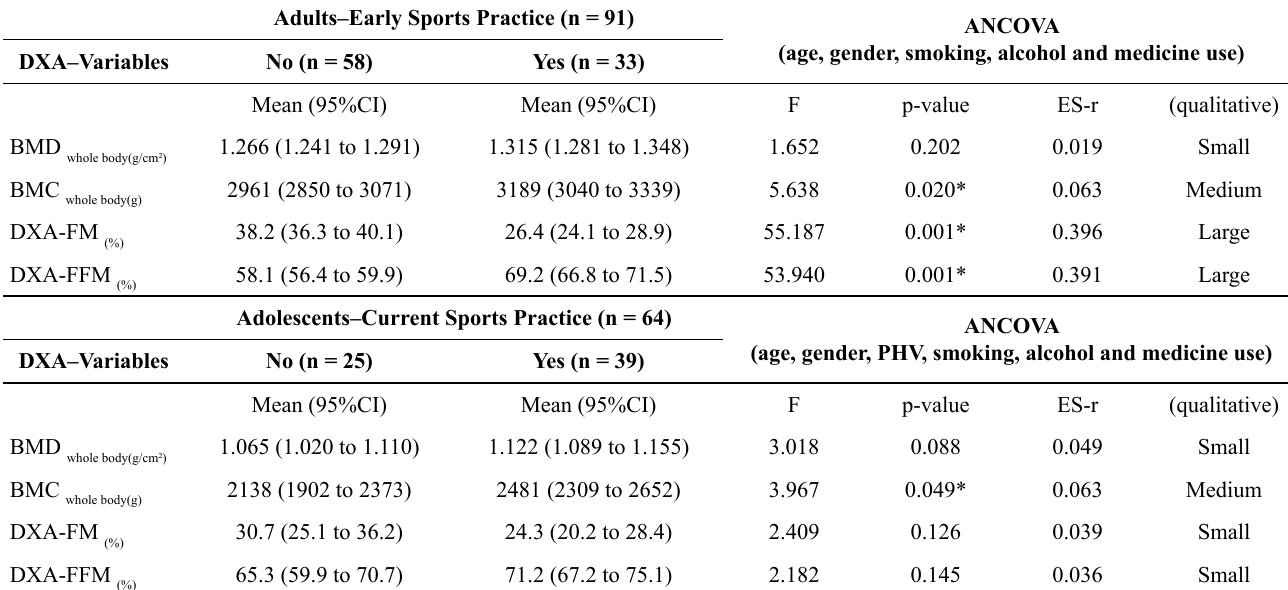
Table 2 . Bone characteristics (ANCOVA estimated means) of the sample stratified by early and current sports practice, respectively (n = 155). Adults–Early Sports Practice (n =